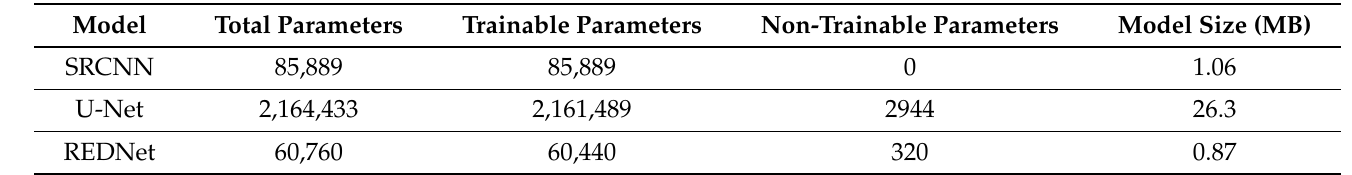
Table 4. Total parameters including the Model parameters (Trainable Parameters and Non-trainable Parameters) and Model Size are shown for all the models.